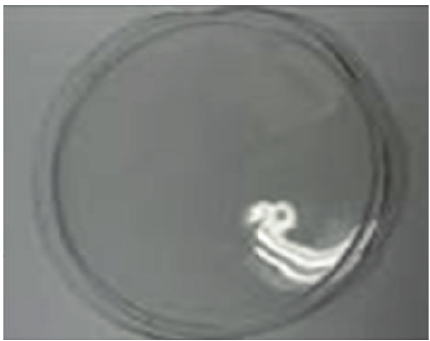
Figure 1: PVA membrane.